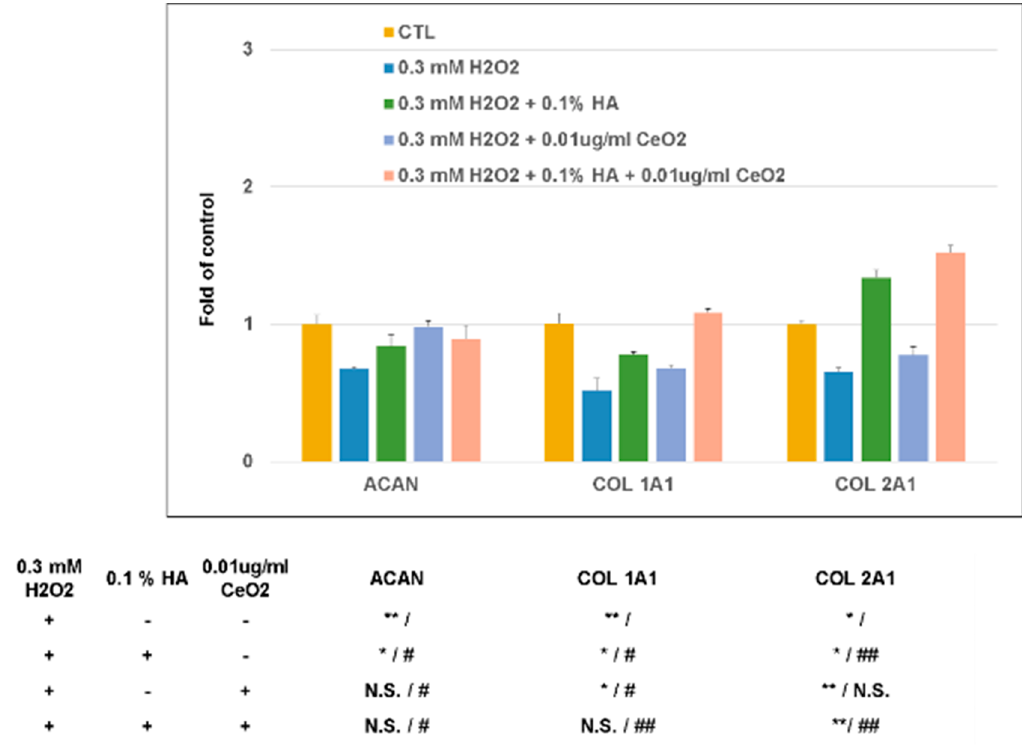
Figure 7. Effect of CeO 2 nanoparticles-loaded hyaluronic acid treatment when chondrocytes under oxidative stress. The presence of HA and CeO 2 can scavenger H 2 O 2 oxidative stress on chondrocytes, while the presence of HA + CeO 2 can further enhance the scavenger effect of HA on the H 2 O 2 oxidative stress induced COL1A1 and COL2A1 gene expression on chondrocytes. * p < 0.05 and ** p < 0.01 when compared with control group; # p < 0.05 and ## p < 0.01 when compared with the H 2 O 2 inducing group.